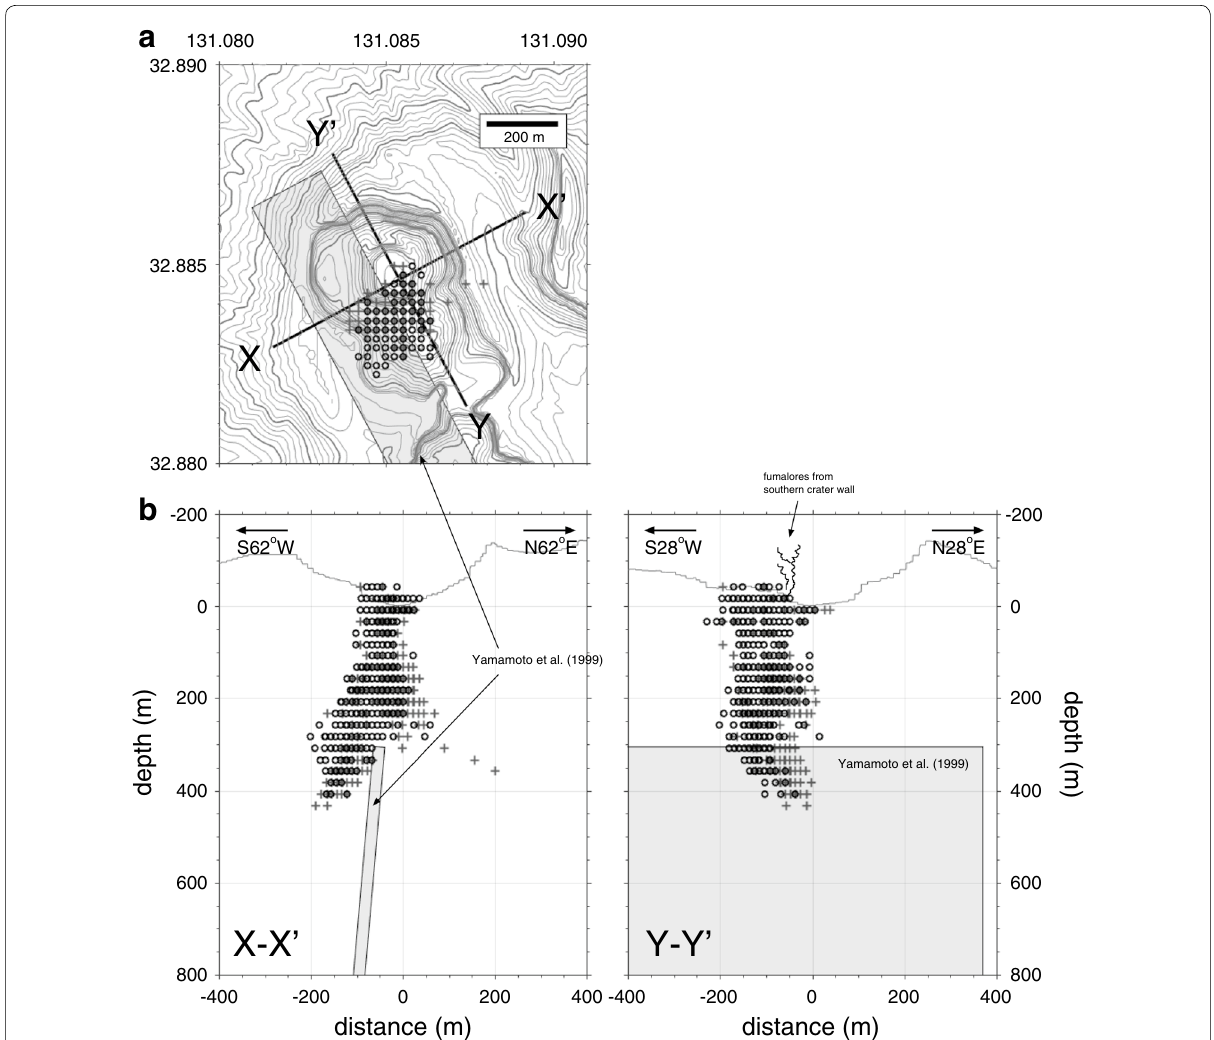
Fig. 9 Distribution of source locations of continuous tremors. Distribution of the source locations of continuous tremors for all stages plotted in a map view and b cross sections based on Fig. 8a–c. The black circles and gray crosses are the results estimated using ten and six station pairs, respectively. The intersection of lines X-X’ and Y-Y’ indicates the center of the crater. Gray shaded areas represent the crack proposed by Yamamoto et al.